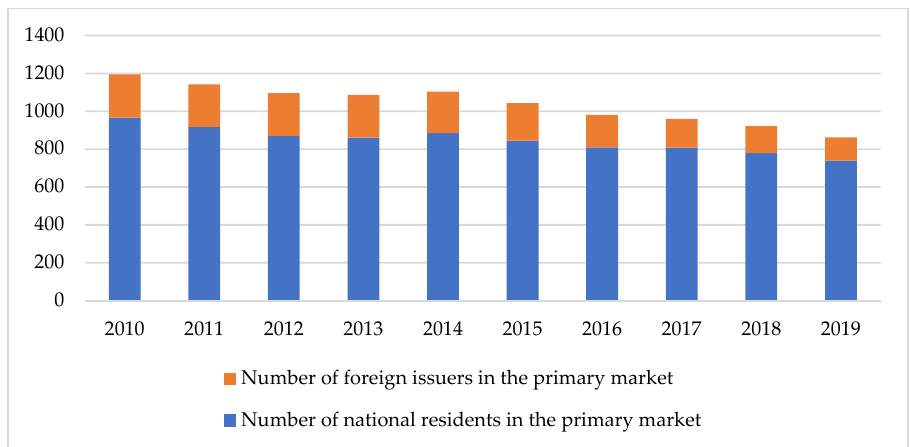
Figure 2. Dynamics of the number of issuers on the London Stock Exchange for 2010–2019. Compiled by the authors on the basis of London Stock Exchange (2021).